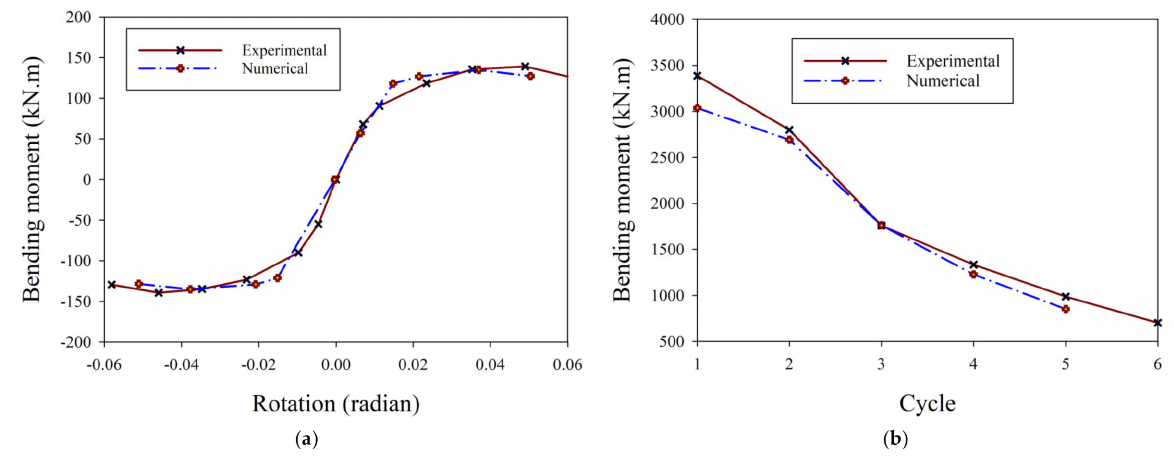
Figure 4. Stiffness changes in different cycles: ( a ) bending moment–rotation relationship, and ( b ) stiffness changes in different